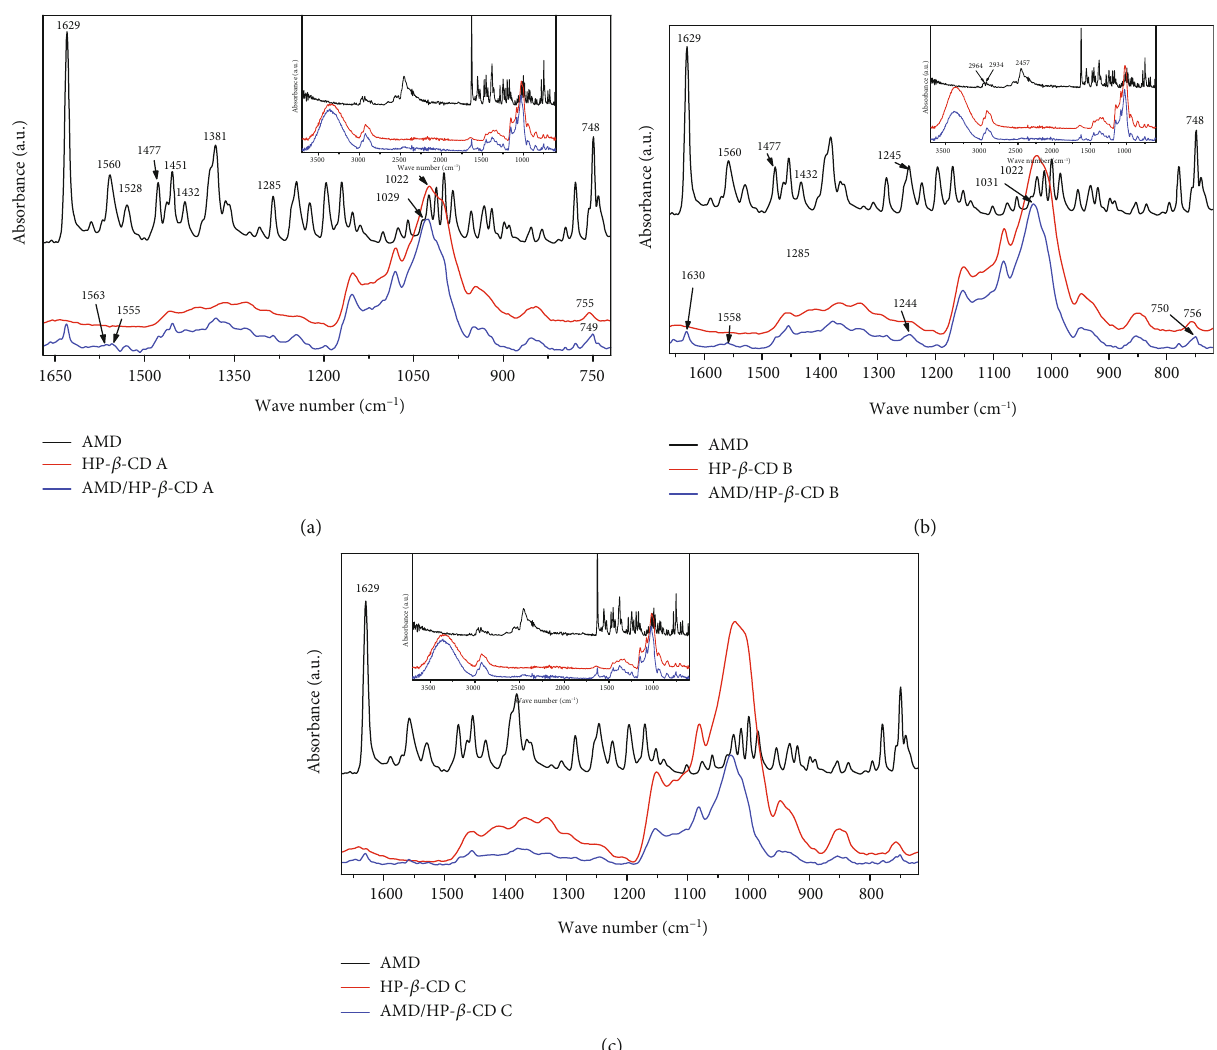
Figure 5: ATR-FTIR spectra of the inclusion complexes of AMD with the three 2-HP- β -CDs: (a) AMD/HP- β -CD A, (b) AMD/HP- β -CD B, and (c) AMD/HP- β -CD C in respect of their